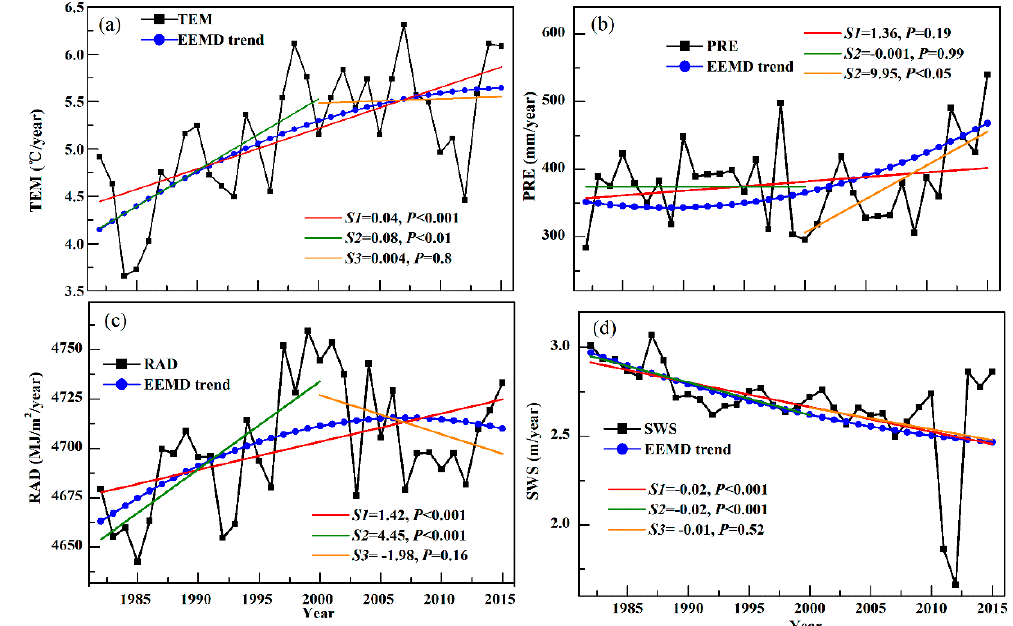
Figure 10. The temporal trend of temperature (TEM) ( a ), precipitation (PRE) ( b ), total downward solar radiation (RAD) ( c ), and near-surface wind speed (SWS) ( d ) in the APENC from 1982 to 2015. S1 , S2 , and S3 represent the slope of each variable from 1982 to 2015, 1982 to 2000, and 2000 to 2015, respectively. Only pixels with P < 0.05 are represented.